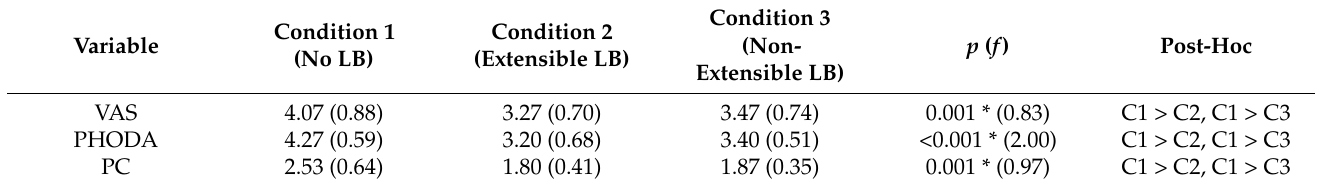
Table 3. Analysis of pain-related psychological variables in the experimental